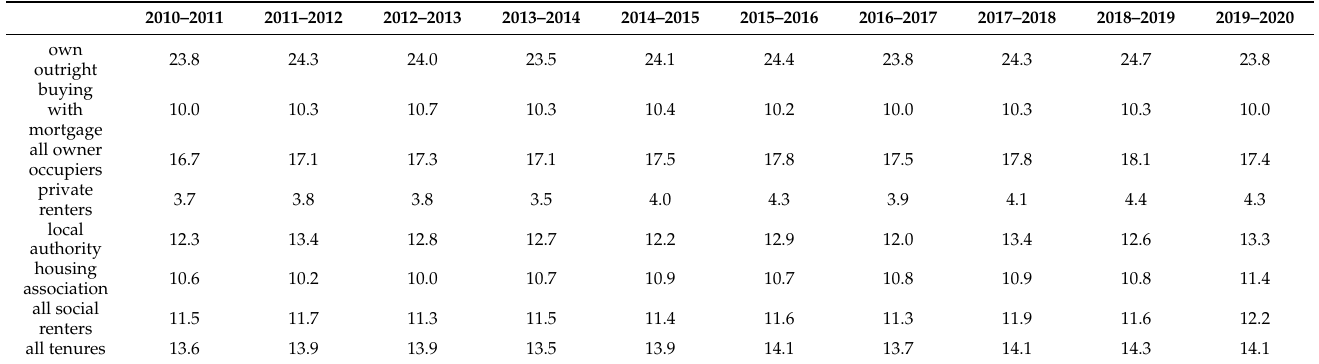
Table A16. Average number of years in current home and in the private rented sector, by tenure,